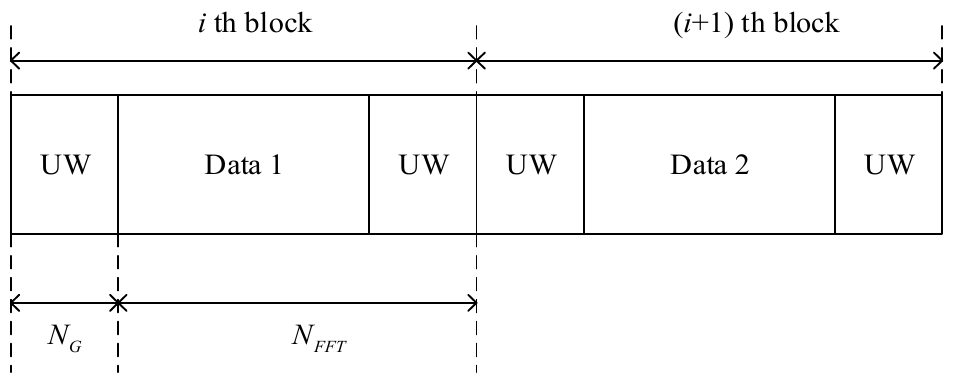
Figure 2. UW-based signal frame structure.